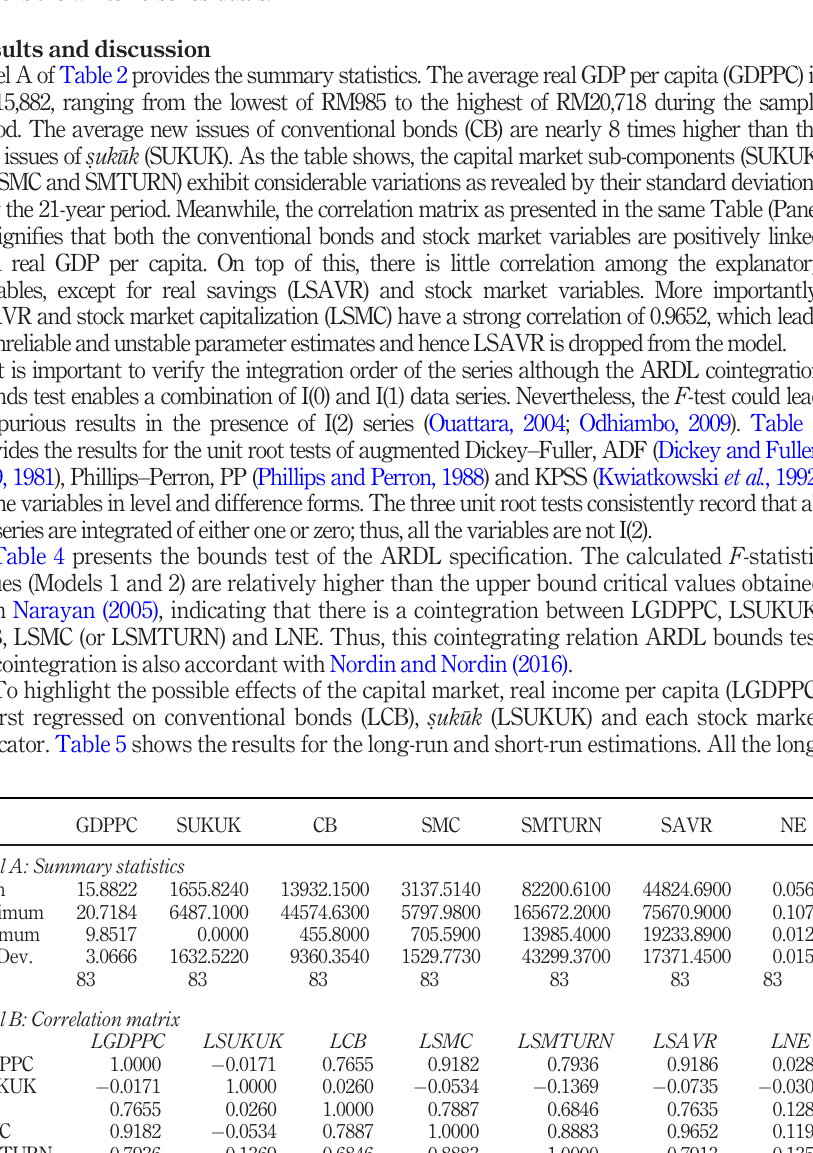
Table 2. Summary